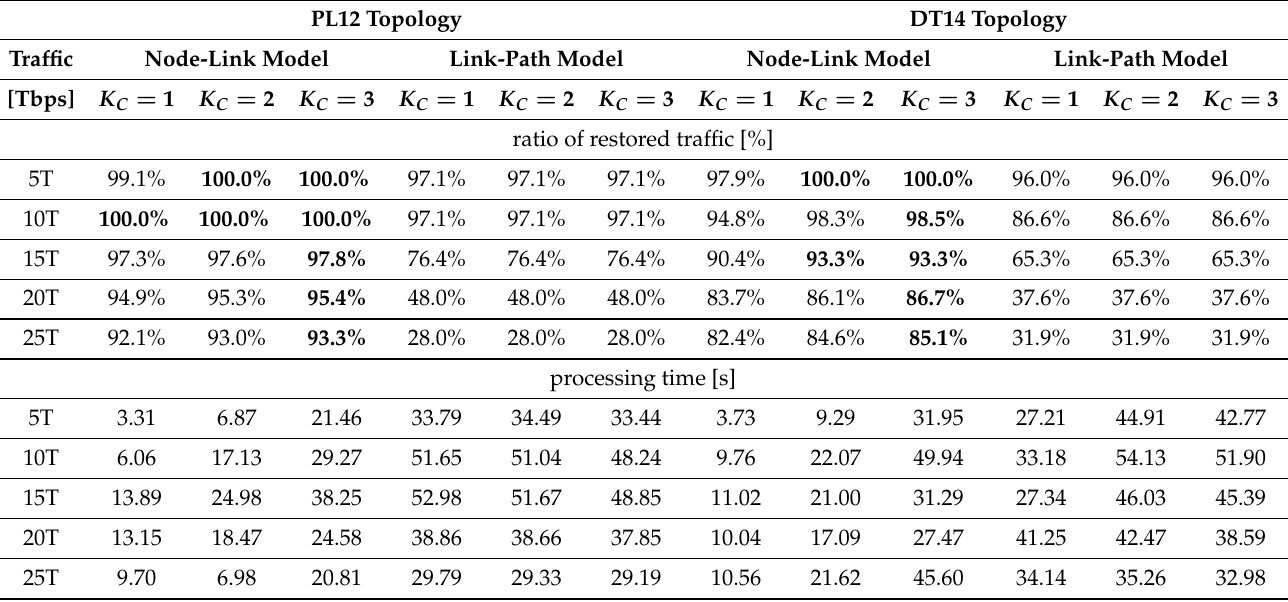
Table 5. Comparison of the node-link and the link-path models for the traffic restoration problem for ρ = 1.0: the average ratio of the restored traffic [%] and the processing time [s] (for each topology and traffic volume, the best result is bold). PL12 Topology DT14 Topology